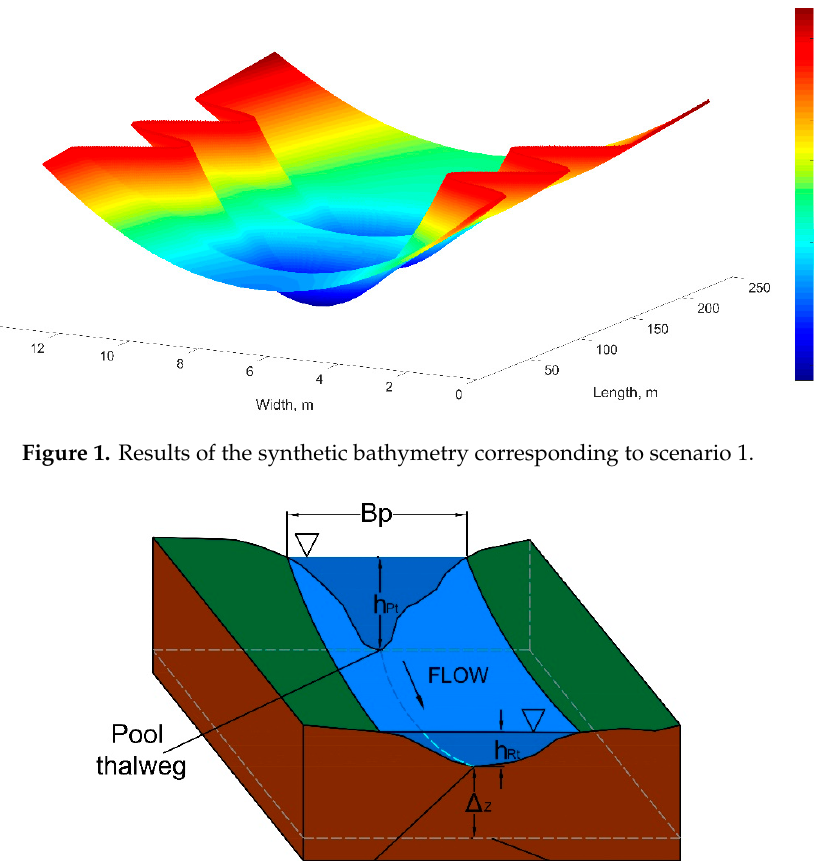
Figure 1. Results of the synthetic bathymetry corresponding to scenario 1.